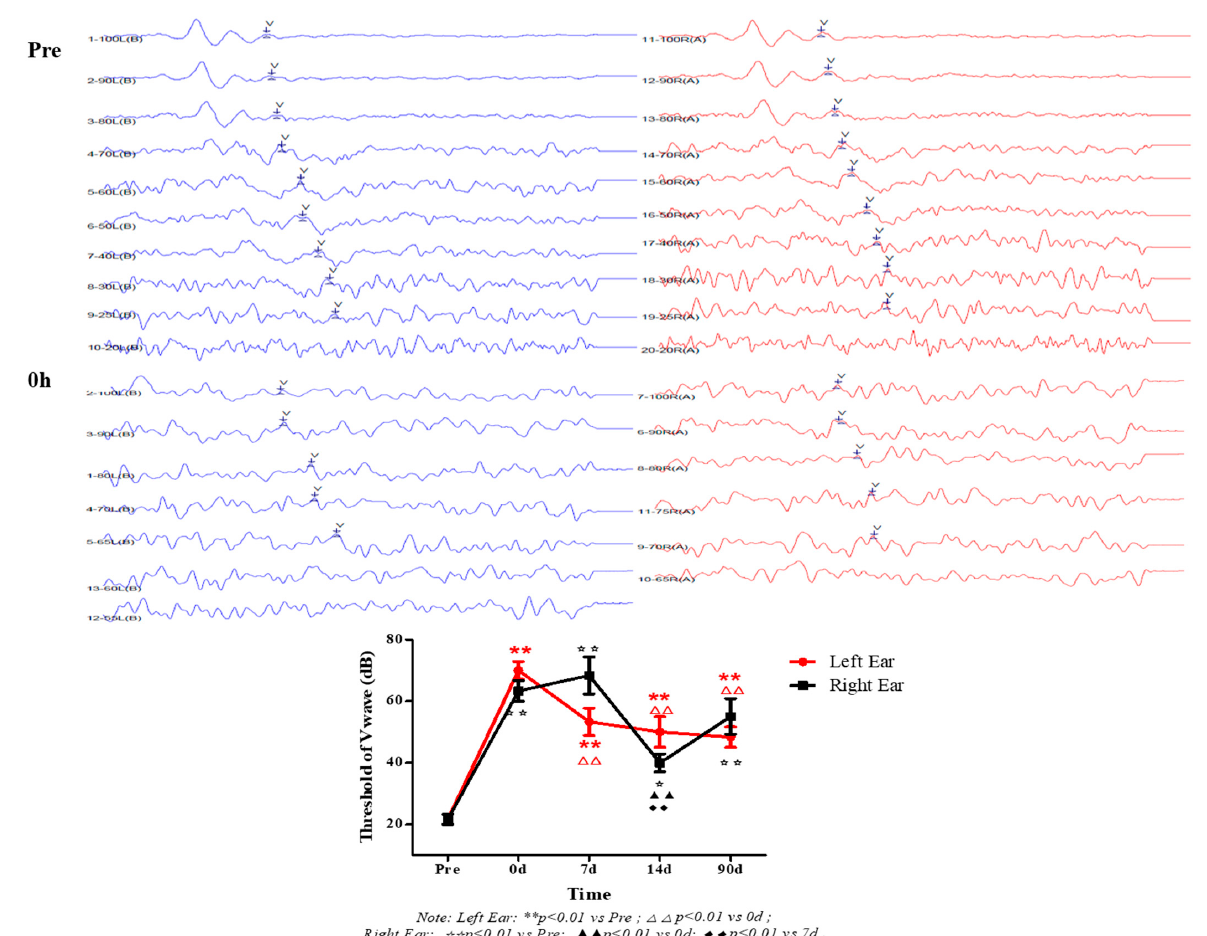
Figure 2. Effects of high level noise exposure on auditory brainstem response in macaque monkeys. Pre and 0 h: ABR waves before and immediately after high level noise exposure, the position indicated by the arrow is wave V of ABR; the line chart is the threshold of wave V at each detection time point.